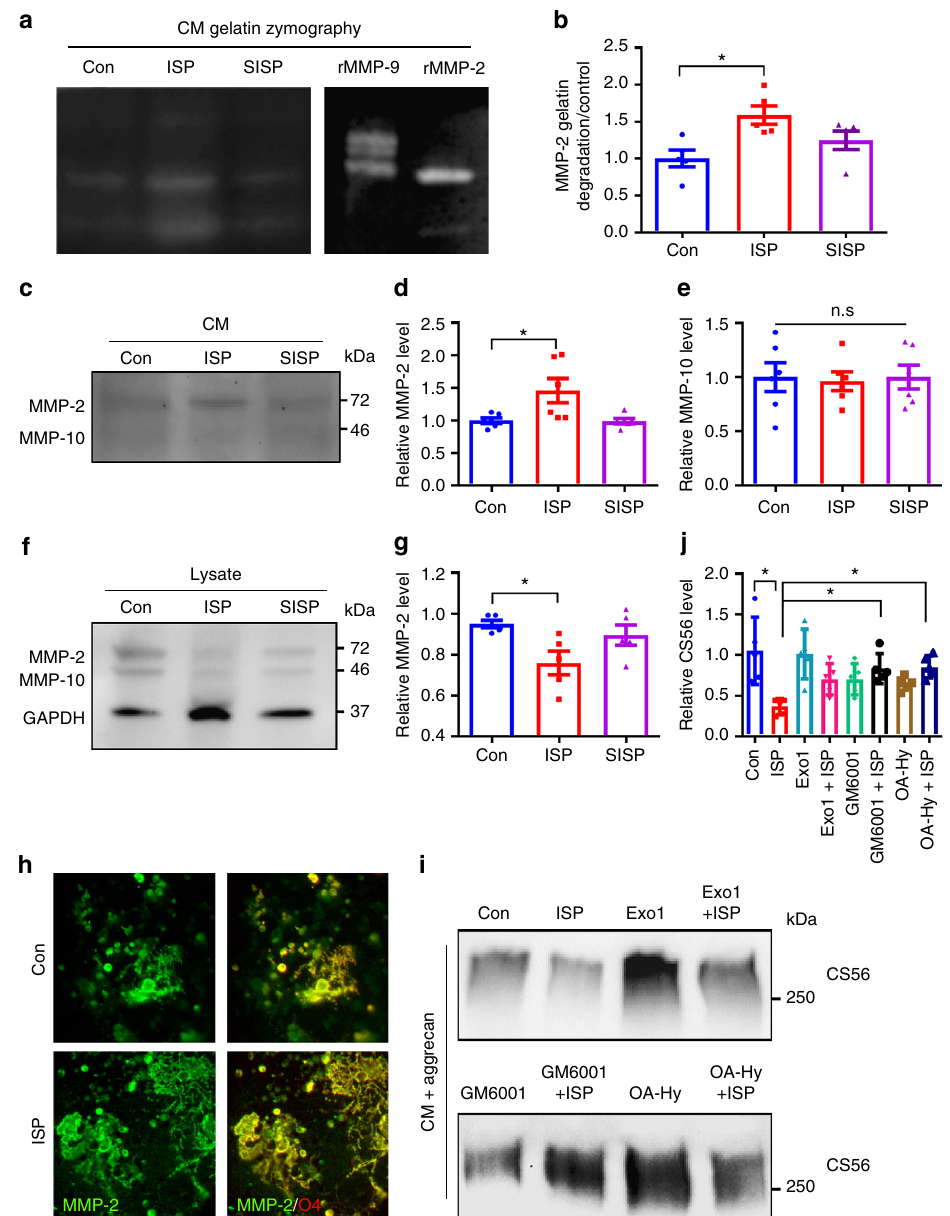
Fig. 6 ISP increases MMP-2 secretion and activity. To further characterize protease activity, a , b cultured OPCs were treated with vehicle control or 2.5 μ M ISP or SISP, concentrated, then loaded onto gelatin SDS/PAGE gels for zymography analysis. 25 ng of recombinant MMP-9 or MMP-2 served as positive controls. Quanti fi cation of active MMP-2 lanes of gelatin zymography reveals signi fi cant MMP-2 activity following ISP treatment over control (One-Way ANOVA, Dunnett ’ s posthoc test, P = 0.0161, F(2,12) = 5.937, N = 5 zymograms). c Enhanced MMP-2 expression following ISP treatment was con fi rmed in western blots of concentrated OPC conditioned media (CM). d Quanti fi cation of MMP-2 immunoblotting was signi fi cantly enhanced following ISP treatment over control (One-Way ANOVA, Dunnett ’ s posthoc test, P = 0.0150, F(2,15) = 5.63, N = 6 western blots). e MMP-10 immunoblotting was not signi fi cant among treatments (One-Way ANOVA, Tukey ’ s posthoc test, P = 0.9619, F(2,15) = 0.03899, N = 6 western blots). f , g Western blot analysis showed a decrease in MMP-2 expression normalized over GAPDH loading control in OPC lysates after ISP treatment. h Immunostaining of O4 + (red) OPCs shows MMP-2 concentrated in OPC soma and processes. Scale bar = 100 μ m. i , j To explore whether ISP induces secretion of proteases to degrade CSPGs, cultured OPCs were treated with the following drugs with or without 2.5 μ M ISP: exocytosis inhibitor Exo1 (10 μ g/mL), general metalloprotease immunoblotted with CS56. Quanti fi cation of CS56 reveals signi fi cant ISP-induced degradation of CSPGs over control, Exo1 + ISP, GM6001 + ISP, and OA- Hy + ISP (One-Way ANOVA, Tukey ’ s posthoc test, P = 0.0010, F(7,32) = 4.749, N = 5 western blots). The data are presented as mean ± s.e.m. * P < 0.05. n.s. not signi fi